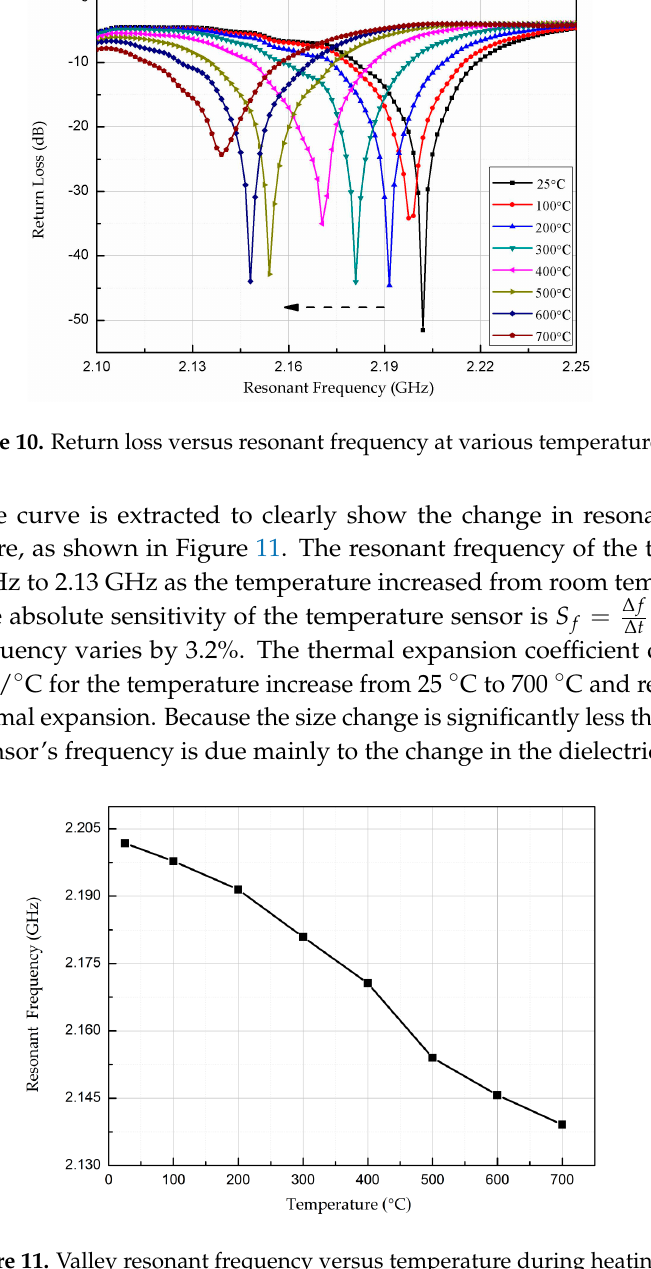
Figure 9. Temperature testing setup.